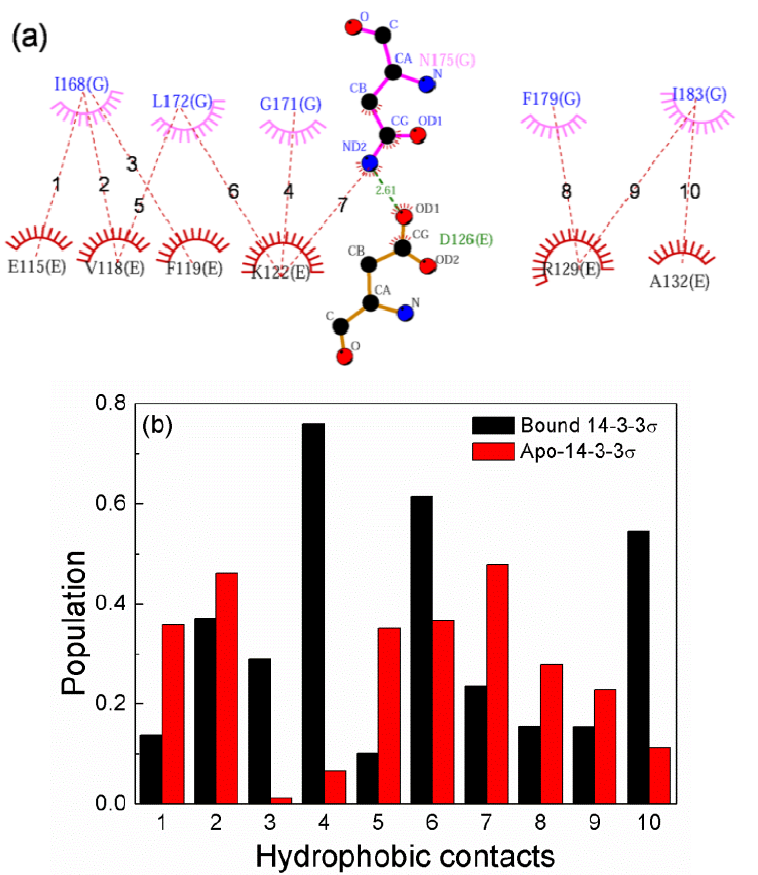
Figure 6. ( a ) Two-dimensional representation for the interactions between helices E and G, the hydrophobic contacts and hydrogen bond are marked with red and green dash line, respectively; ( b ) The populations of ten hydrophobic contacts (labeled in Figure 9a) in the last 60 ns MD